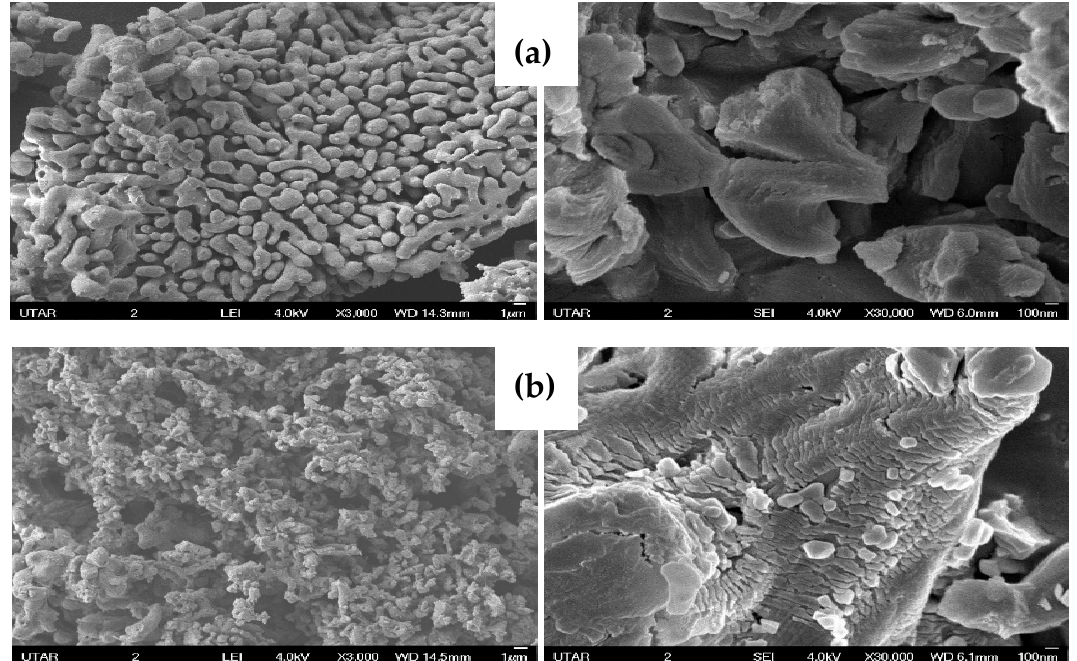
Figure 2. FESEM images of calcined eggshell at ( a ) 900 °C and ( b ) 1100 °C with 3000× and 30,000× magnification.